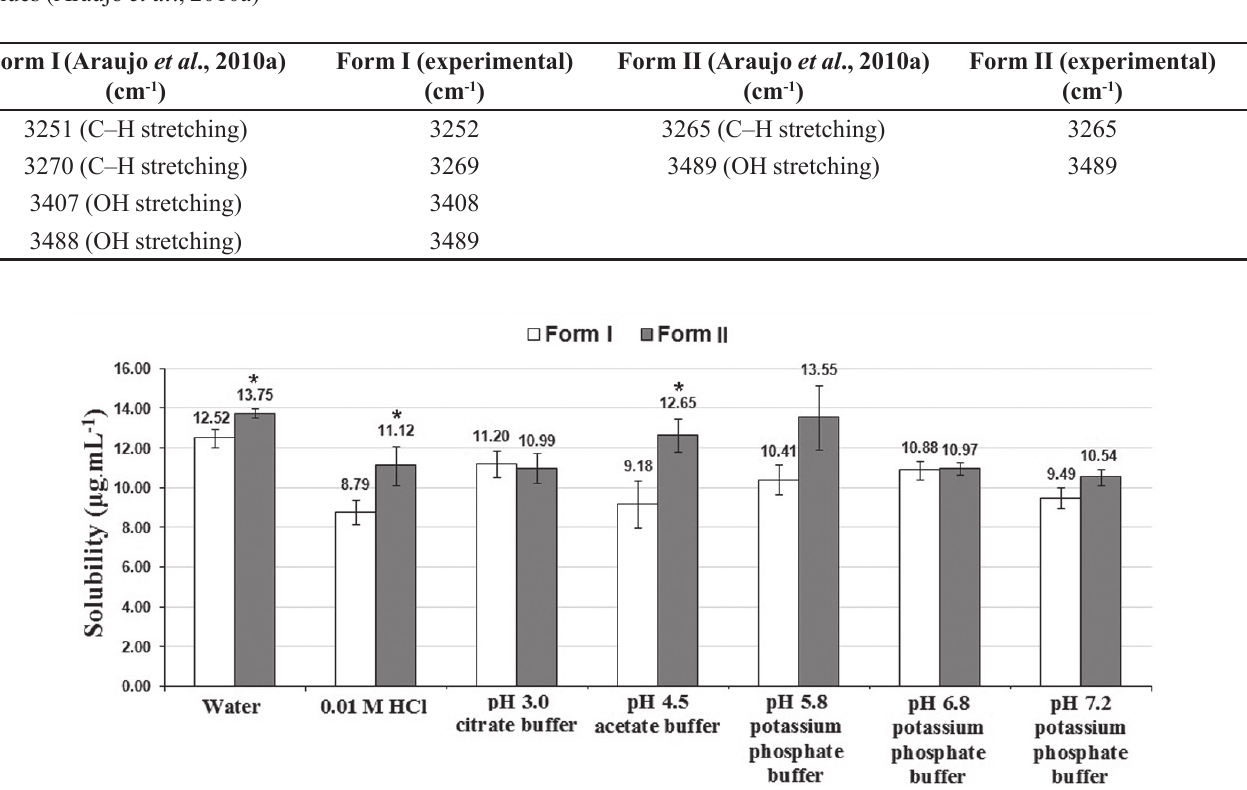
TABLE II - Major absorption bands from FTIR-ATR spectra (300-3500 cm -1 ) of tibolone forms I and II in comparison with reported values (Araujo et al ., 2010a)